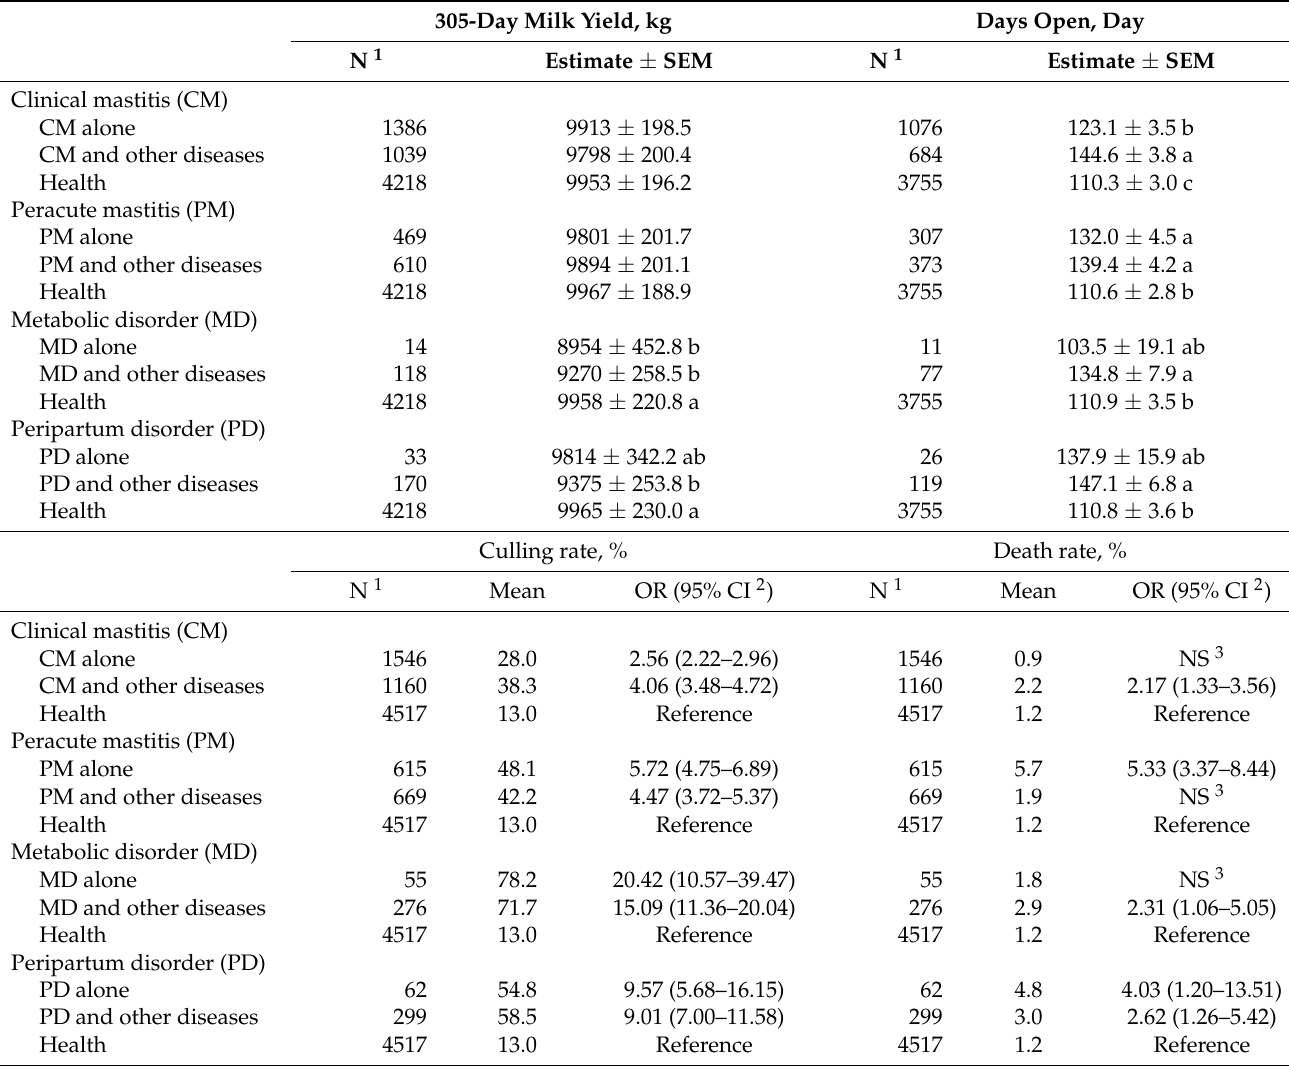
Table 2. Comparison of productivity among disease status. 305-Day Milk Yield, kg Days Open, Day N